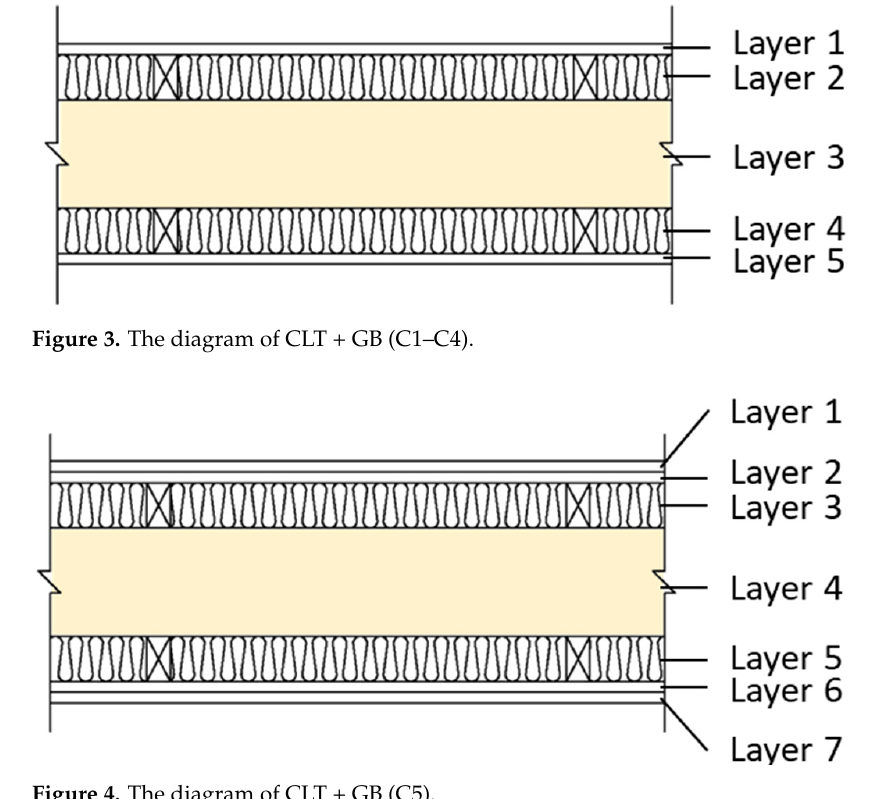
Figure 4. The diagram of CLT + GB (C5).